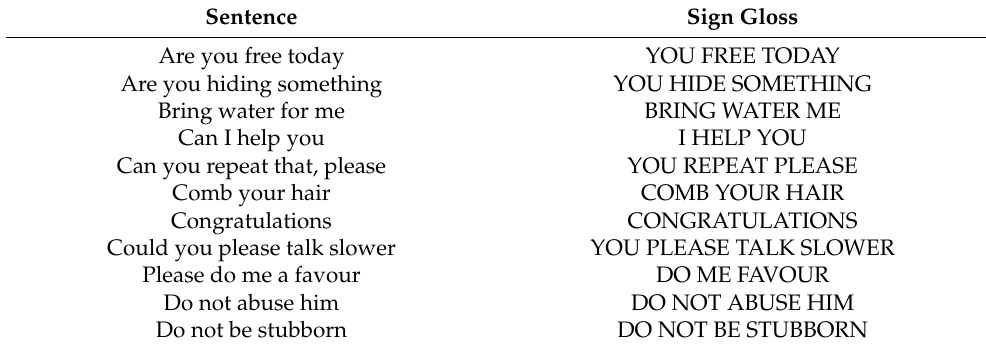
Table 2. Ground truth with sign gloss representation.